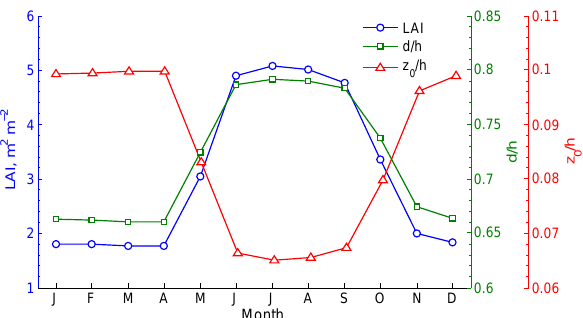
Figure 2. Monthly variation of leaf area index (LAI), the displace- ment height ( d) to canopy height ( h) ratio, and the roughness length ( z 0 ) to canopy height ratio at Harvard Forest.